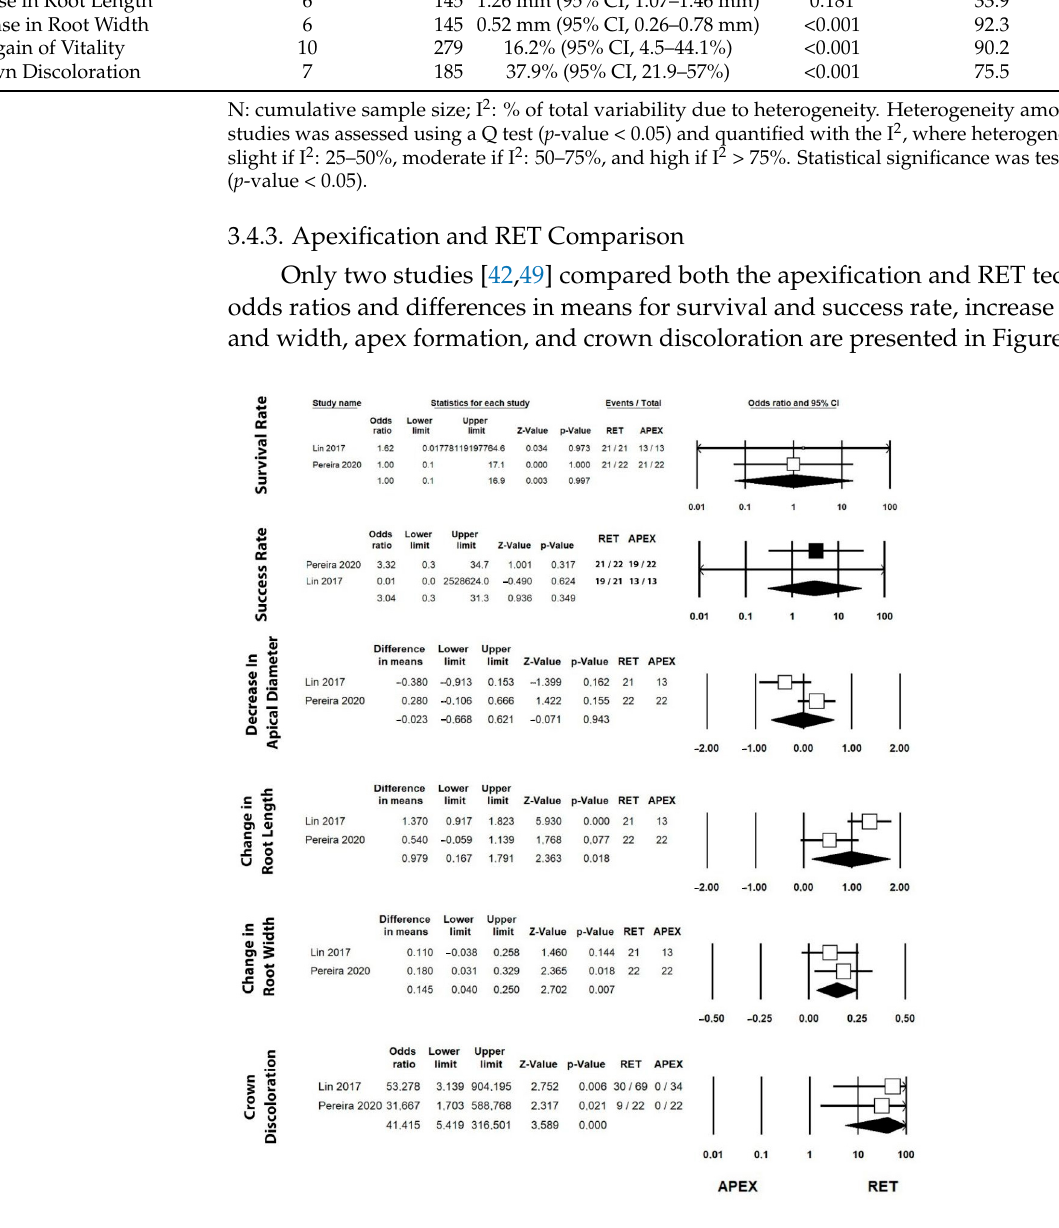
Figure 4. Forest plot of estimated odds ratio and di ff erence in means for the studied variables com- paring RET and apexi fi cation techniques. Results of two studies that compared the apexi fi cation and RET techniques